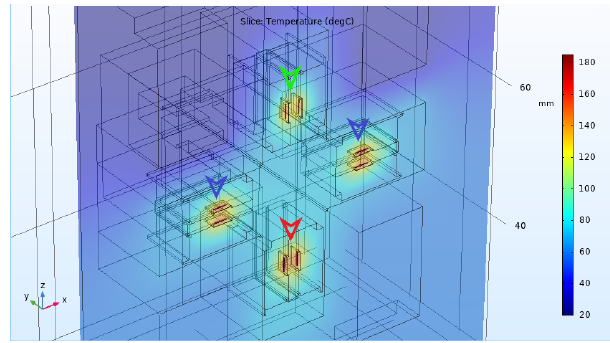
FIGURE 11. Heat Distribution and Maximum Temperatures in °C. The markers are linked to the curves depicted in figure 12, according to their